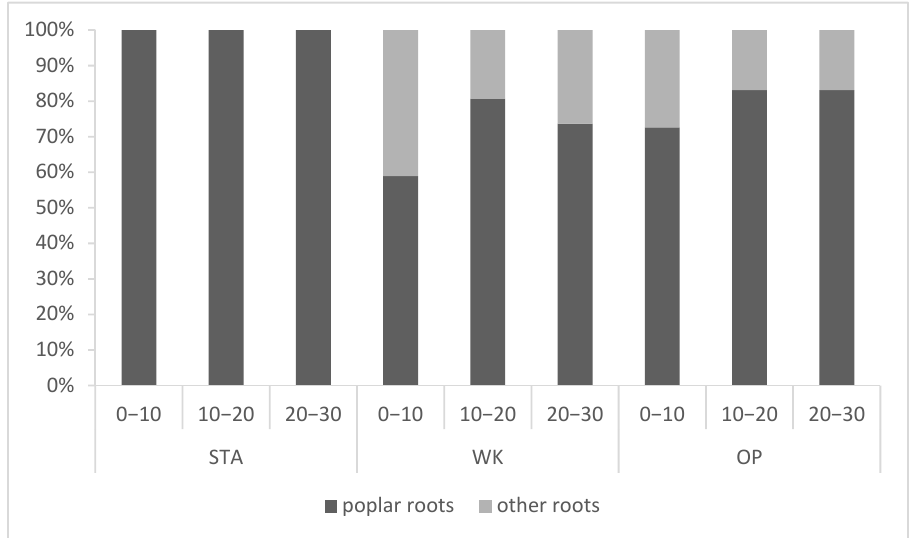
Figure 1. The contribution of the total length of roots of poplars and other plants in the samples in